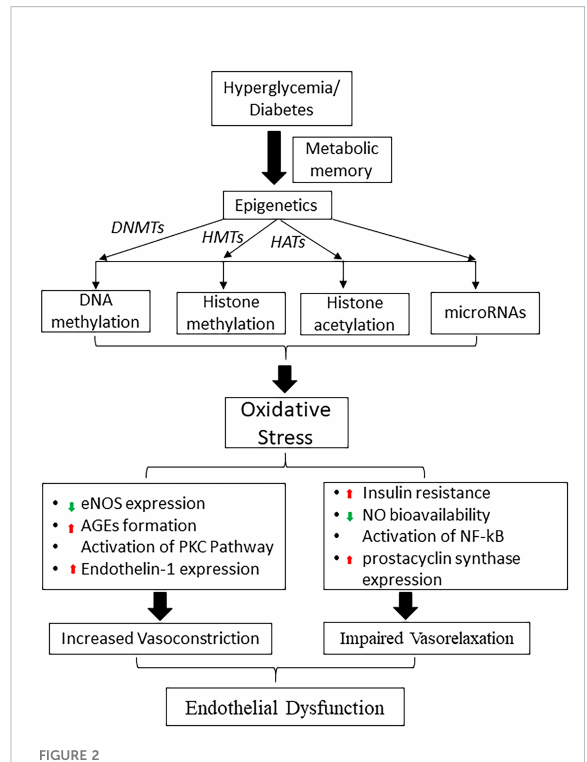
FIGURE 2 Schematic diagram shows the role of hyperglycemia